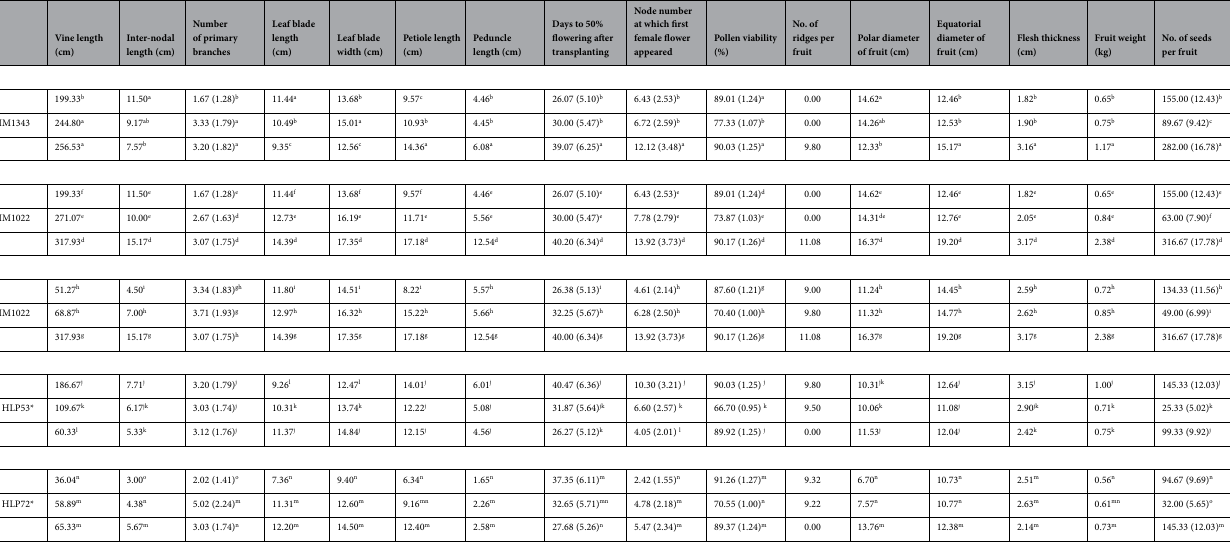
Table 4. Morphological (quantitative) characterization of interspecific hybrids and their parents. Mean values with different letters in a respective family number’s column are significantly different at P ≤ 0.05 according to Tukey’s HSD (Honest Significant Difference) test. Family numbers are designated with different letters as: Family I: a–c, Family II: d–f, Family III: g–i, Family IV: j–l, Family V: m–o. Figures in parentheses are the means of square root and arc sine transformed values. *Derived through ovule culture.